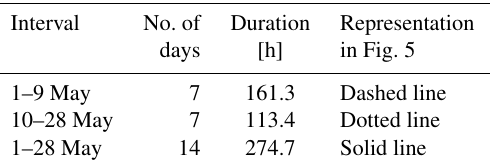
Table 1. Time intervals in May 2016 for the composite analysis and the related number of days and measurement hours during each